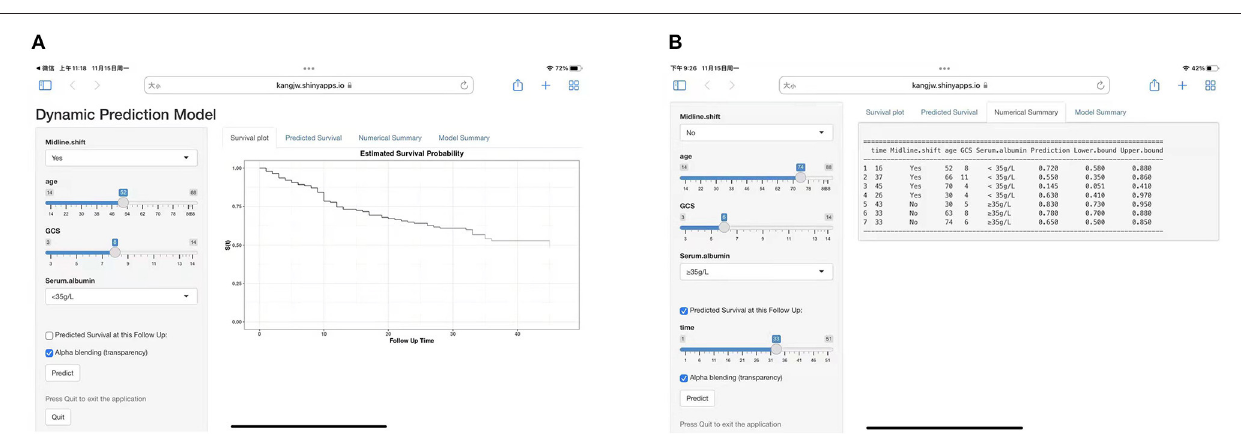
FIGURE 3 | Construction of a web-based calculator for predicting DOC’s disease survival based on the model (https://kangjw.shinyapps.io/P-Doc/). (A) Web survival rate calculator. (B) 95% confidence interval (CI) of the web survival rate